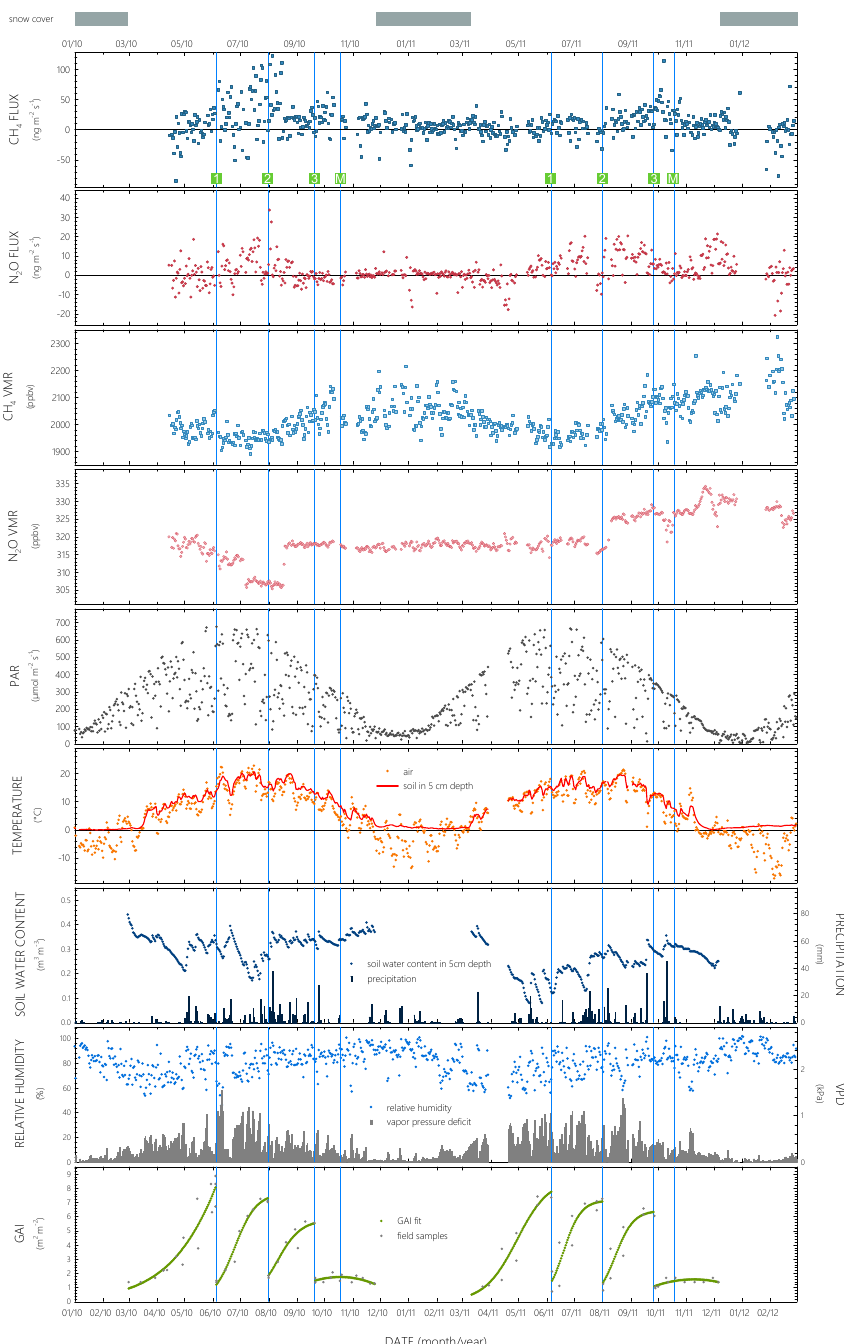
Figure 2. Daily average CH 4 and N 2 O fluxes and volume mixing ratios (VMRs), photosynthetically active radiation (PAR), air temperature, soil temperature at 5cm depth, soil water content at 5cm depth, relative air humidity, vapor pressure deficit, green plant area index (GAI) and daily sums of precipitation over 22 months of measurements between April 2010 and February 2012. Vertical lines show management dates, the numbers 1, 2 and 3 in green squares indicate the first, second and third cutting of the meadow, respectively, while M denotes manure